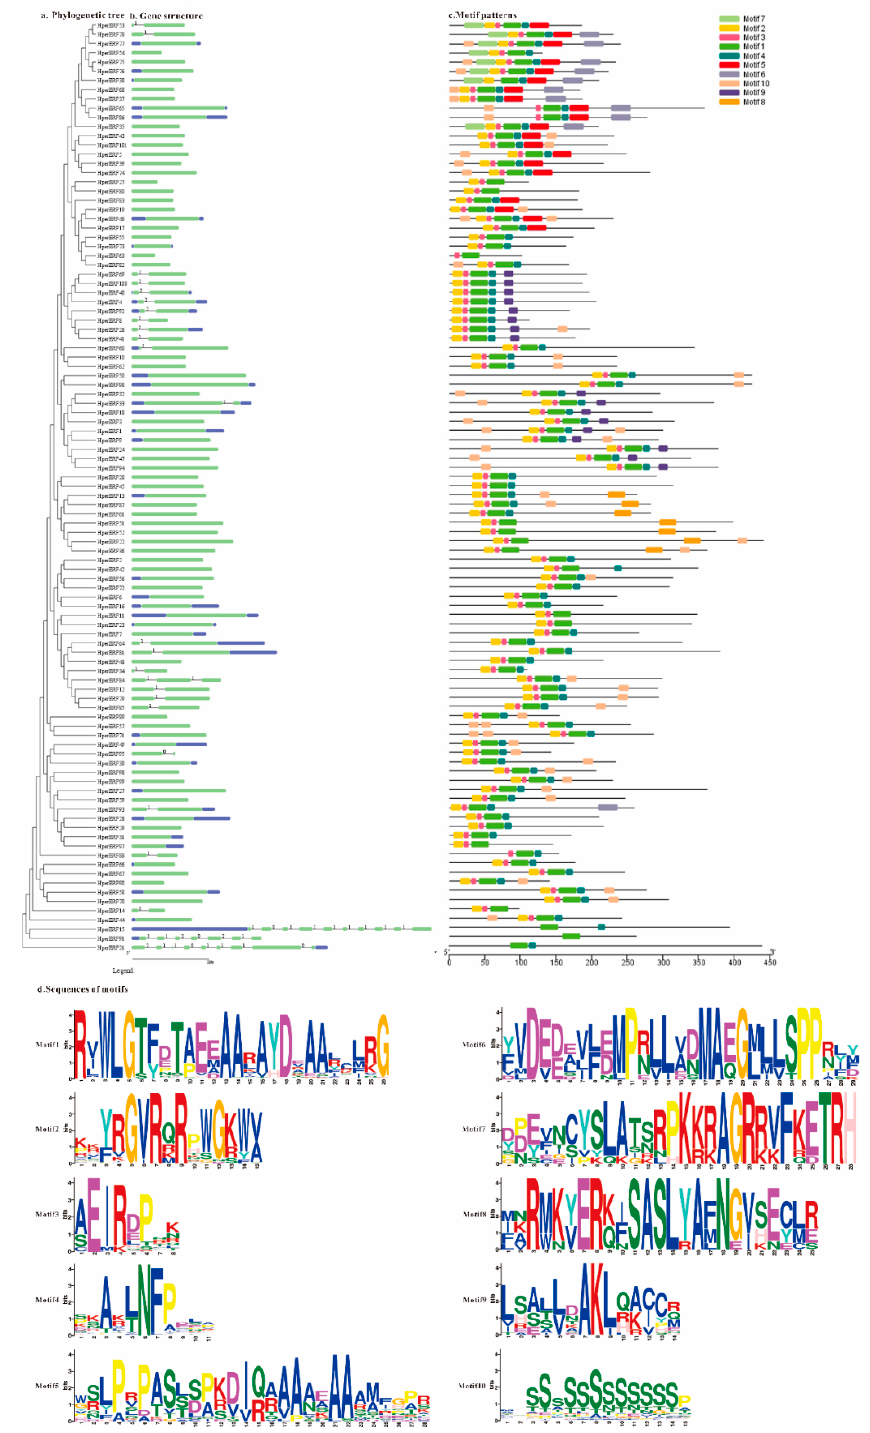
Figure 4. The phylogenetic relationships, gene structure, and composition of conserved motifs in ERFs from H. perforatum . ( a ) The phylogenetic tree on the left contains 101 ERF proteins (named HpERF1 to HpERF101) from H. perforatum . ( b ) Exon/intron structures of ERF genes from H. perforatum . Exon(s) and intron(s) are displayed by green boxes and black lines, respectively, while the untranslated regions are indicated by blue boxes. The number manifested the phases of according to the introns of HpERFs . ( c ) The motif patterns of 101 HpERF proteins. Each motif is showed by the box in different colors. ( d ) Sequence logos of each